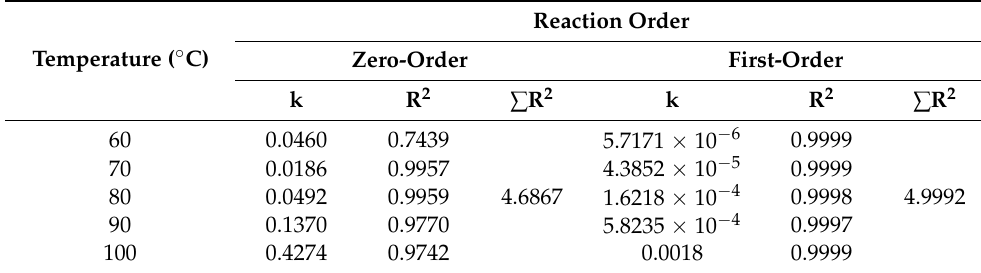
Figure 5. First-order kinetic model for the thermal degradation of IPBC at different heating tempera- tures: ( a ) 60–100 ◦ C; ( b ) 110–150 ◦ C. Table 1. Reaction rate constants and coefficients of IPBC during thermal degradation from 60 ◦ C to 100 ◦